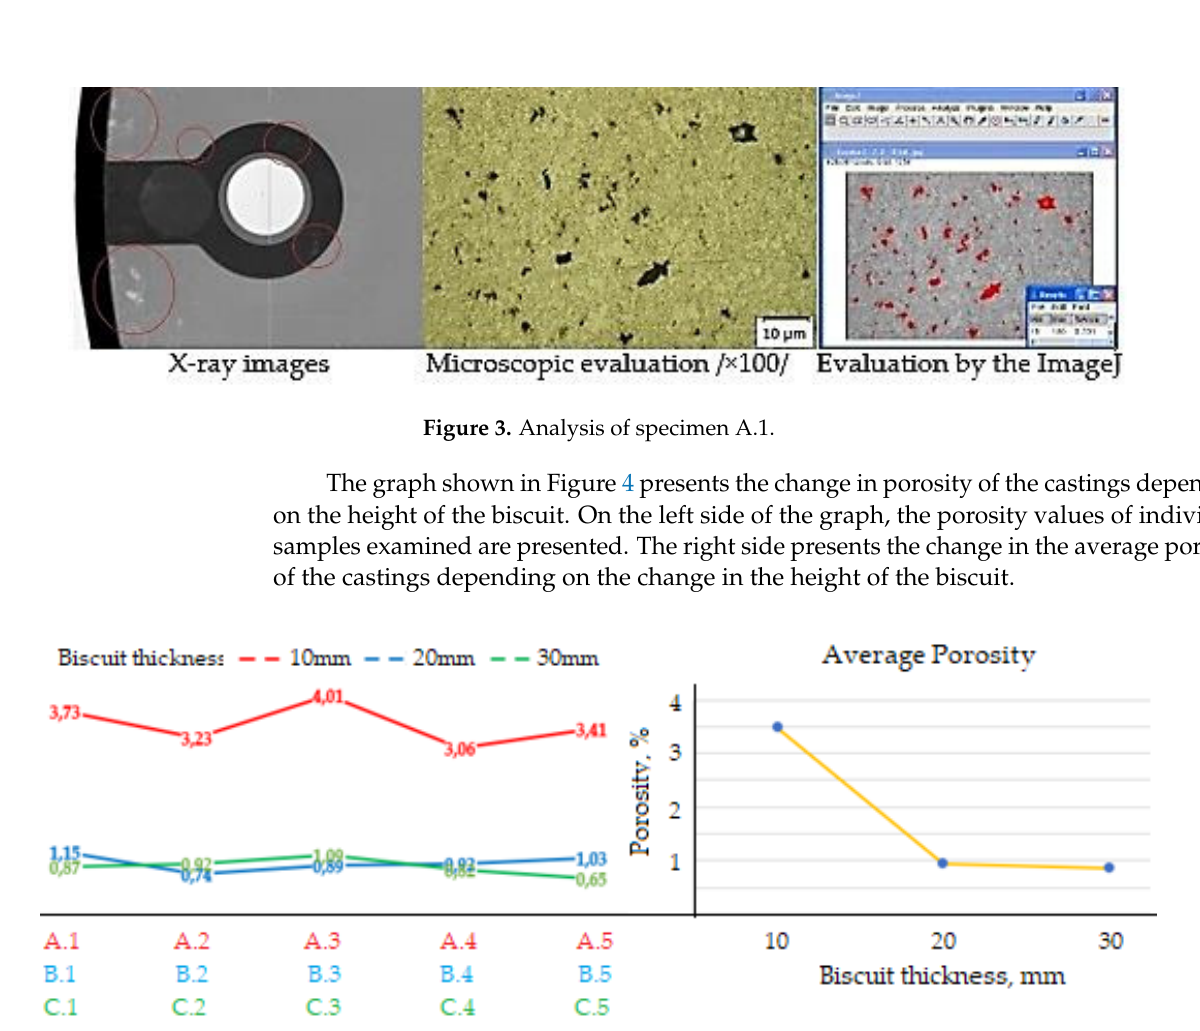
Figure 4. Porosity change dependence on biscuit height.